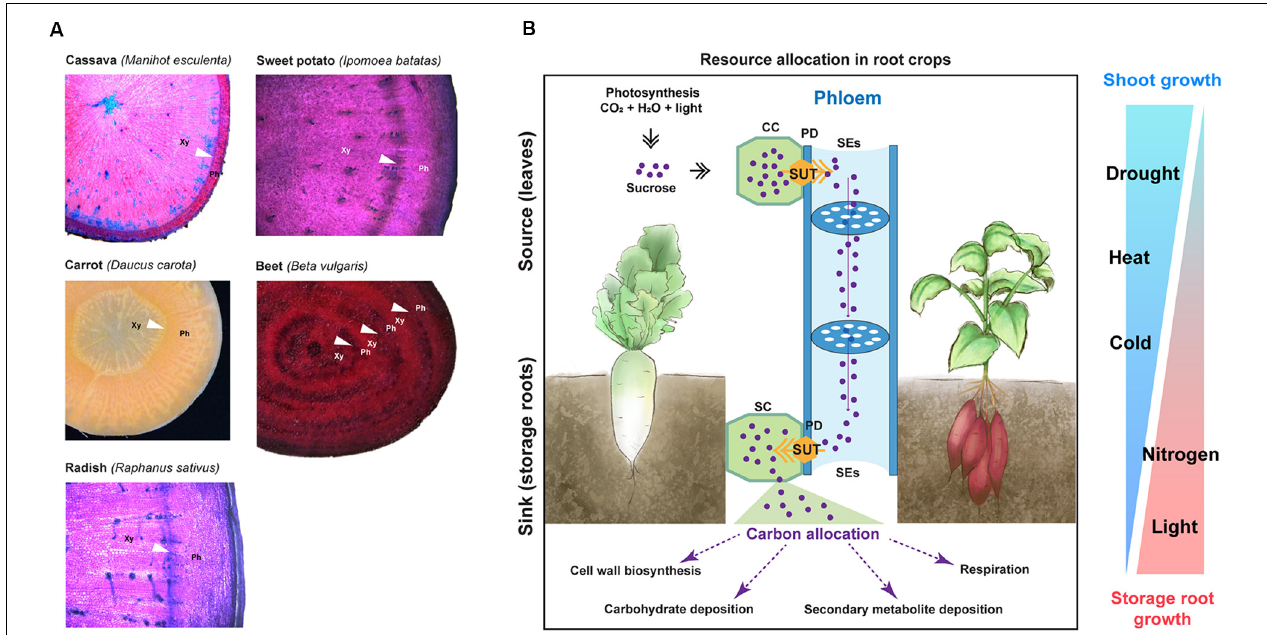
FIGURE 2 | Anatomy of storage roots and environmental factors influencing storage root development. (A) Root cross-sections of major root crops including cassava, sweet potato, carrot, sugar beet, and radish. Cross-sections of cassava, sweet potato, and radish were stained with toluidine blue. Images for sugar beet and cassava were adapted from Barba-Espin et al. (2018) and Mehdi et al. (2019), respectively, which are distributed under the Creative Commons Attribution 4.0 International Licenses (https://creativecommons.org/licenses/by/4.0/). Arrow heads point to cambia. Xy, xylem side; and Ph, phloem side. (B) A simplified scheme depicting resource relocation from source (leaves) to sink (roots); and environmental factors influencing storage root formation and biomass in root crops. SUT, sugar transporter; CC, companion cell; PD, plasmodesmata; SE, sieve element; and SC, sink cell. On the right panel, the width of each triangle represents the influencing level of environmental factors on shoot growth (blue color) and storage root growth (red